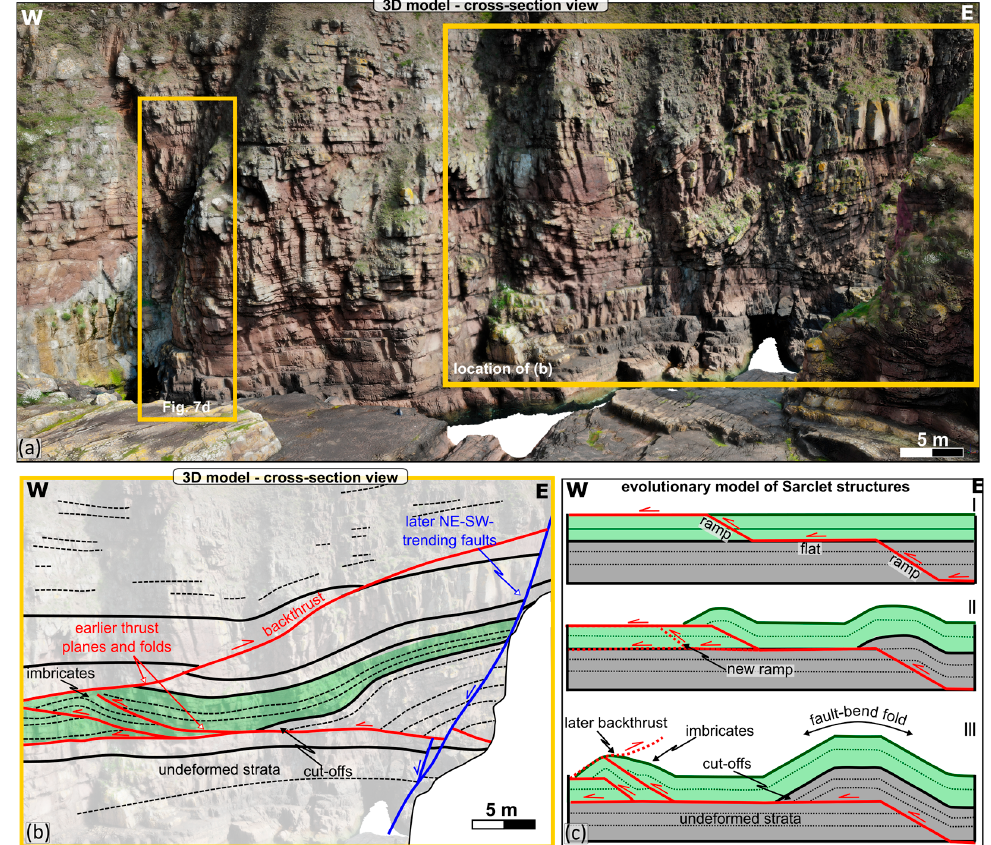
Figure 5. ( a ) Three-dimensional digital outcrop model of the cliff exposure at Sarclet Haven (see location in Figure 4b) showing the folded and faulted Devonian strata. The location of ( b ) and Figure 7d are indicated on the 3D outcrop. ( b ) Line drawing showing the interpreted early detachment-related structures offset by later NE–SW-trending faults. ( c ) Forward model explaining the possible evolution of the detachment structures.